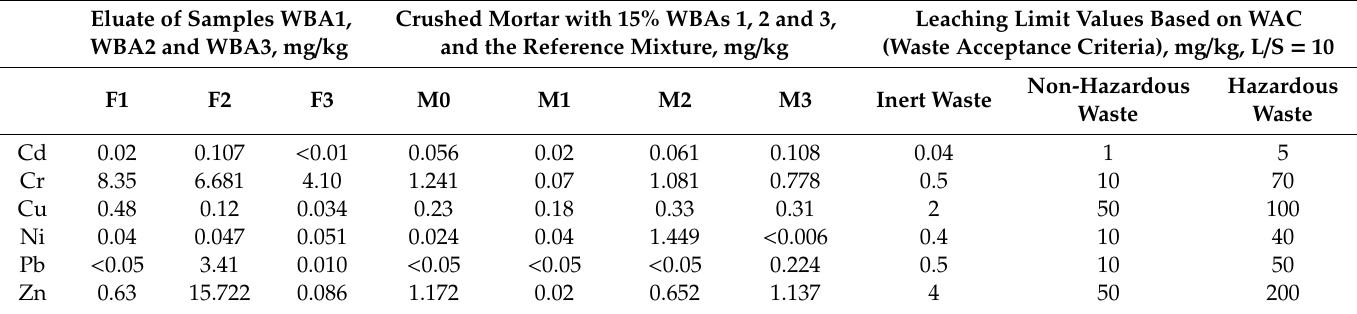
Table 6. Heavy metal concentrations and limited values for the individual waste categories